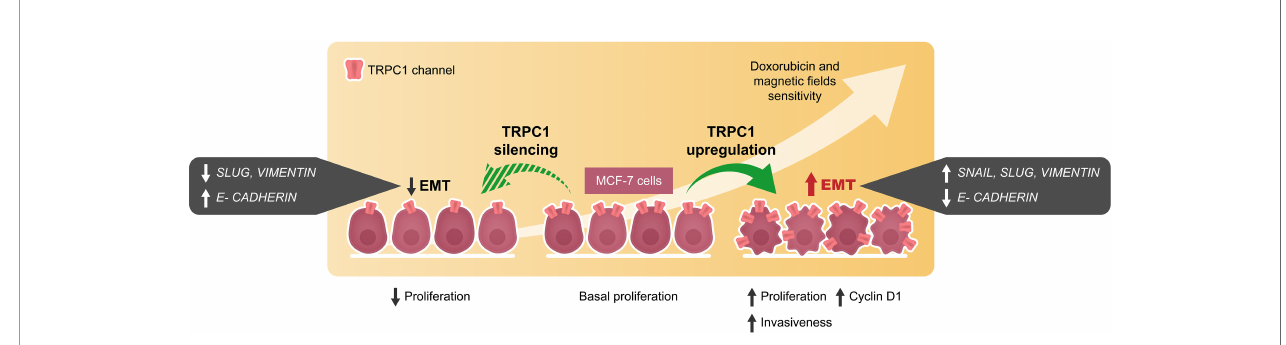
FIGURE 9 | Schematic representation of cellular events modulated by the overexpression and silencing of TRPC1 in MCF-7 breast cancer cells. EMT and invasiveness were shown to correlate with TRPC1 expression in breast cancer cells providing an opportunity for the development of synergistic companion magnetic and doxorubicin therapies that selectively target TRPC1 for the treatment of cancer classes characterized by elevated expression of